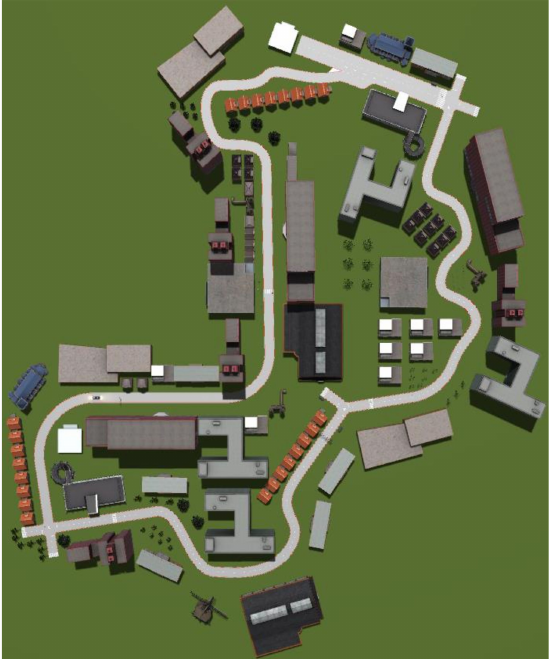
Figure 2. Driving scene in Perscan.